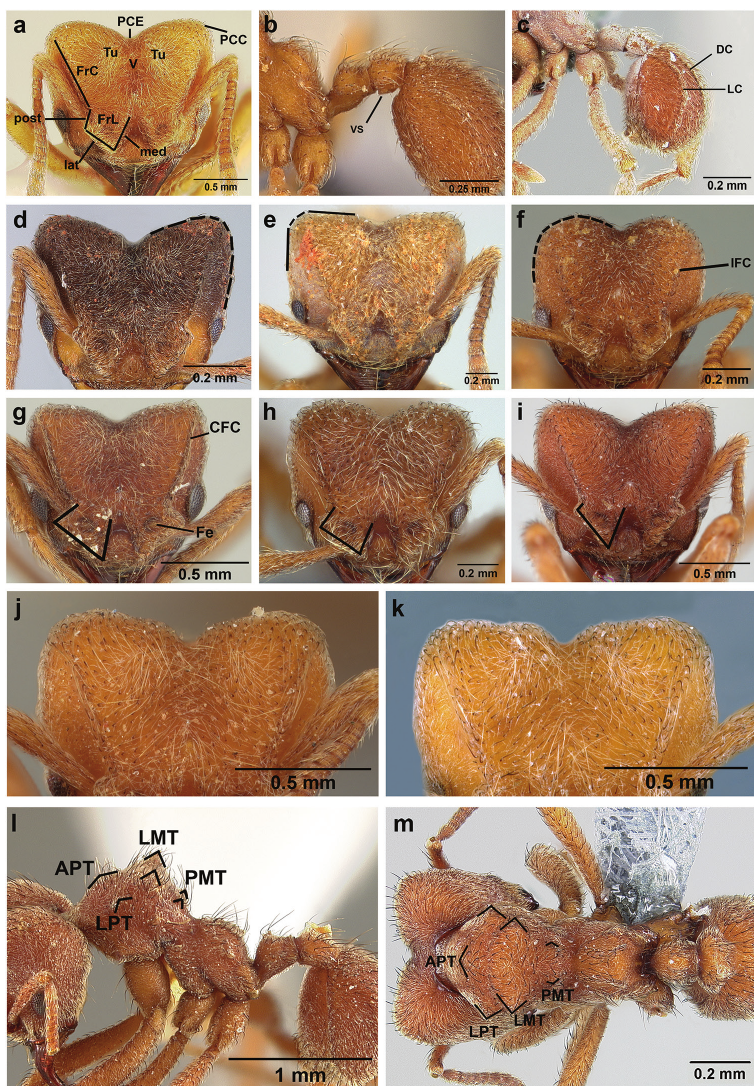
Figure 7. Sericomyrmex worker morphology and terminology. a Head, full-face view b petiole and post- petiole, lateral view; c metasoma, lateral view. Posterior cephalic corner shapes: d acute e rectangular f rounded. Frontal lobe shapes: g trapeziform h rectangular i triangular. Posterior cephalic border shapes: j posterior cephalic border gradually impressed k posterior cephalic border abruptly impressed. Meso- soma morphology: l mesosoma, lateral view m mesosoma, dorsal view. PCC Posterior cephalic corner PCE posterior cephalic emargination Tu tumulus V vertexal impression FrC frontal carina FrL frontal lobe post posterior frontal lobe margin lat lateral frontal lobe margin med medial frontal lobe margin vs postpetiolar ventral sternite LC longitudinal lateral gastral carina DC anteromedial dorsal gastral carina IFC incomplete frontal carina CFC complete frontal carina Fe frontal lobe fenestra APT an- terior pronotal tumulus LPT lateral pronotal tubercle LMT lateral mesonotal tubercle PMT posterior mesonotal